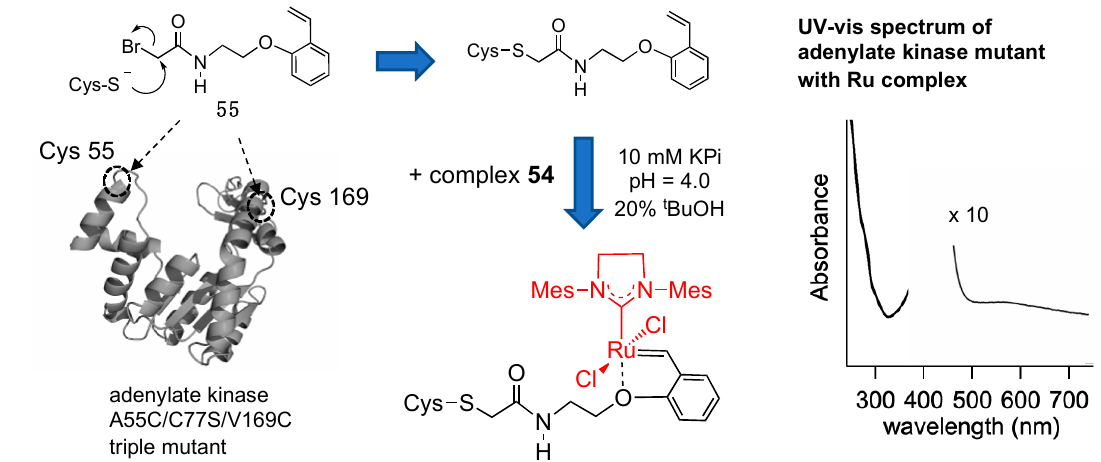
Figure 14. Immobilization of ruthenium complex onto the surface of the adenylate kinase triple mutant (A55C/C77S/V169C) through ligand exchange strategy [66].